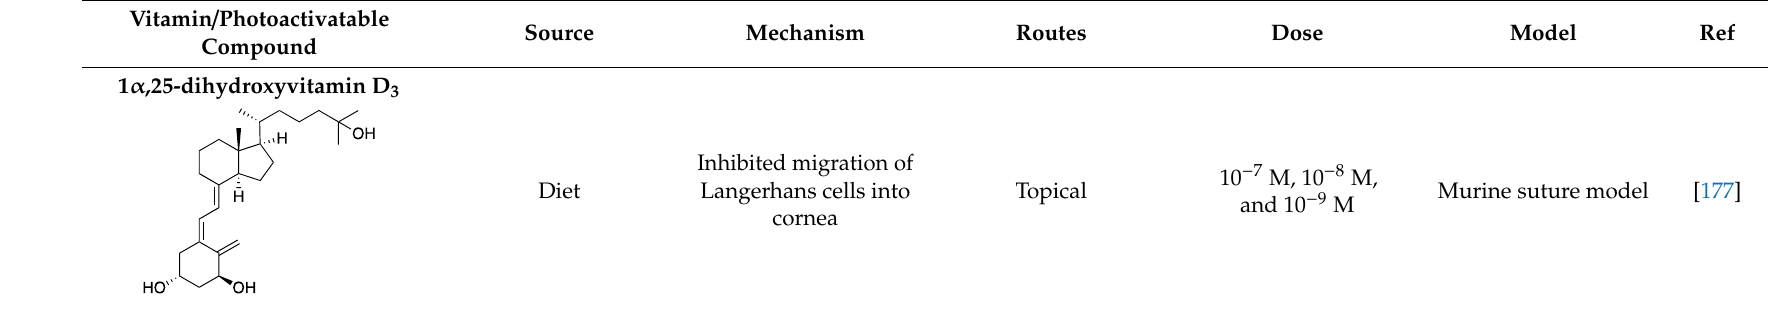
Table 8. HDAC inhibitors tested in CoNV models.